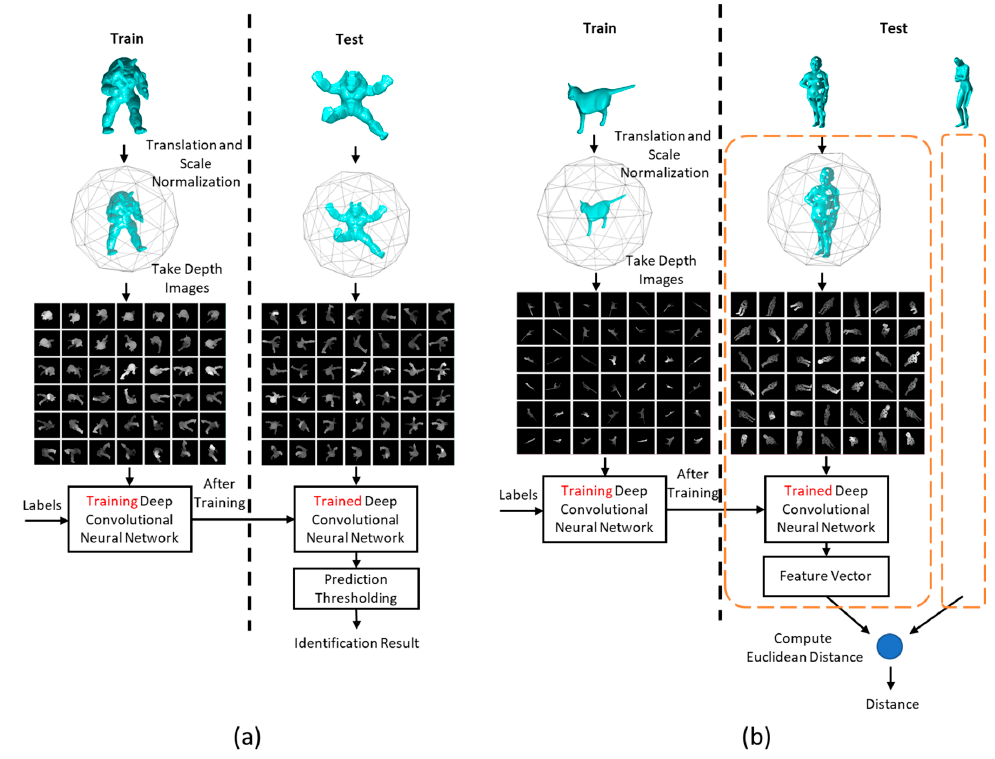
Figure 1b. Then, the distance of two 3D models can be computed using the Euclidean distance of the corresponding feature vectors. Appl. Sci. 2017 , 7 , 988